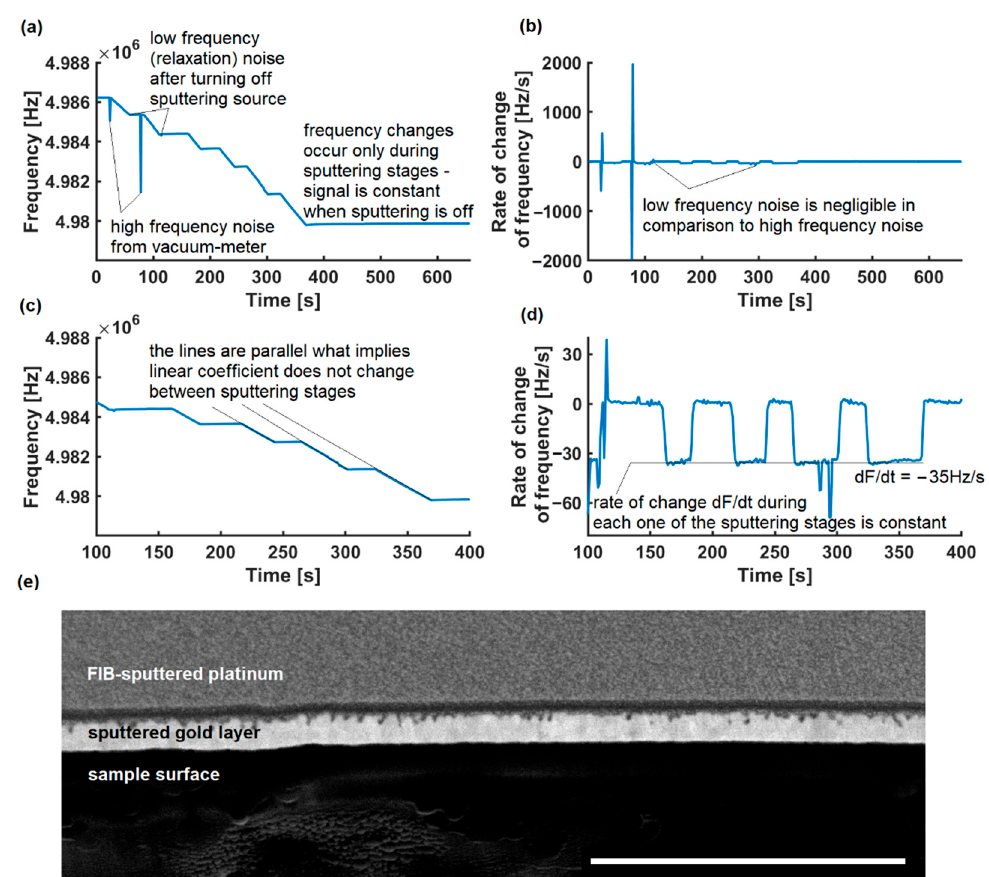
Figure 4. The process of gold sputtering, is divided into stages: ( a ) The frequency signal during experiment; ( b ) the rate of change during experiment; ( c ) magnified view for time t = [100, 400] s, showing the tangent lines during deposition stages are parallel; ( d ) the rate of change during deposition in the time interval is constant unlike in Figure 3; ( e ) FIB-SEM cross section of examined rock sample, scalebar 1 µm.